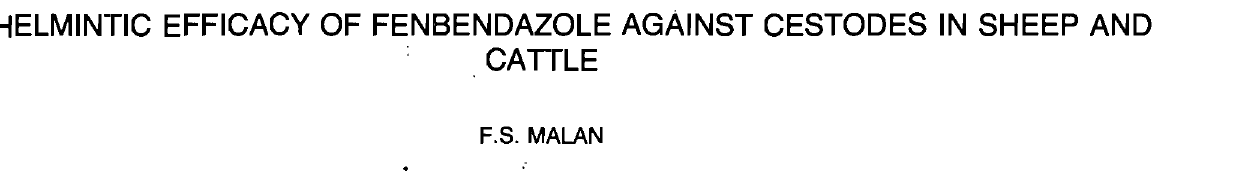
AT 10 m.g/kg BODY MASS